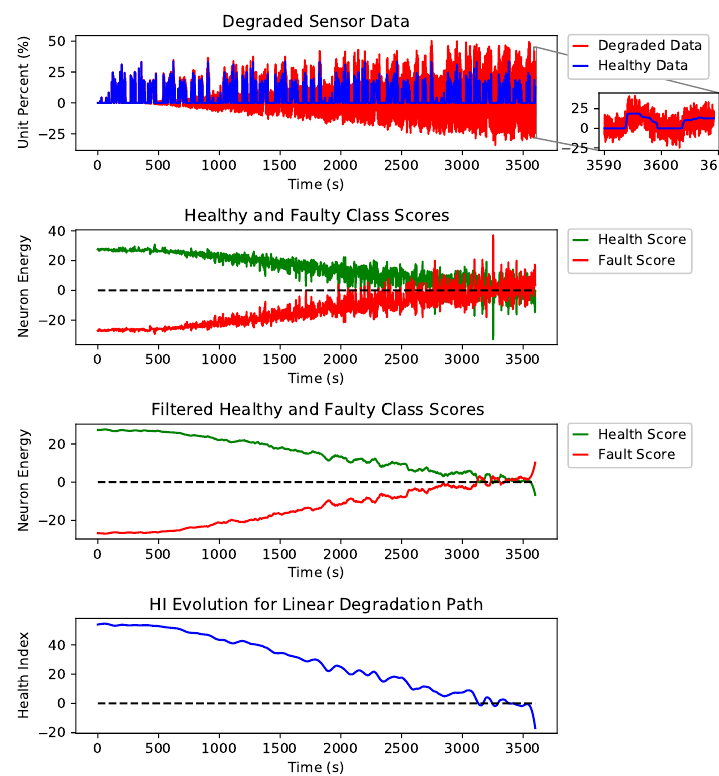
Figure 8. Steps taken to construct the HI from a linearly degraded AccP data stream.